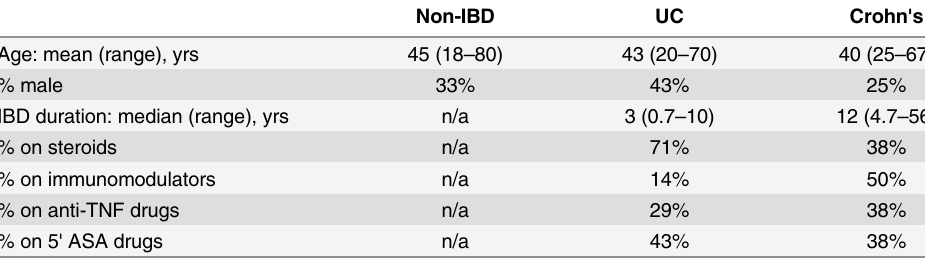
Table 1. Characteristics of Patients from Whom Intestine Was